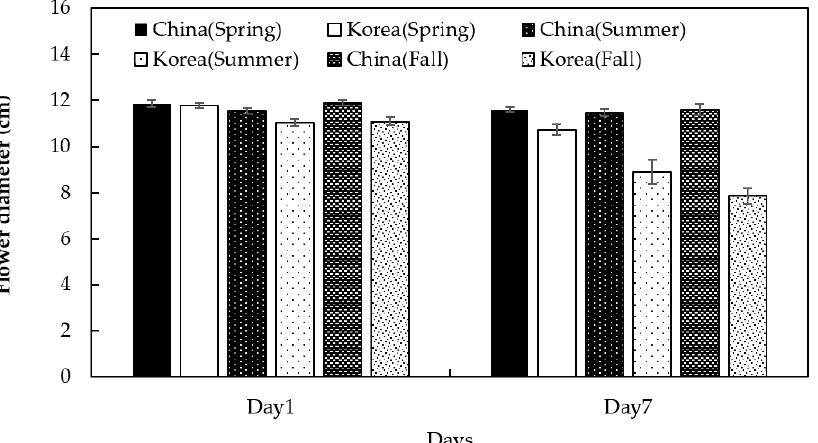
Figure 1. Flower diameter of cut Phalaenopsis “V3” flowers based on the place of origin and season on day 1 and day 7 of the experiment when the senescence type was observed. The relative fresh weight was lower in Korean cut flowers with a shorter vase life than in Chinese flowers on day 5 of the experiment, across all three seasons (Figure 2A), and the margin of decrease was the lowest in autumn when the vase life of the Korean and Chinese cut flowers was longer than during the other seasons. Based on this, the water uptake (Figure 2B) showed an increase on day 3 of the experiment, followed by a decrease on day 5, with lower levels across Korean flowers for all three seasons, as was the case with the relative fresh weight. Phalaenopsis is sold in bloom, but like Curcuma and Oni- sogalum, the leaves do not stick to the stem when cut, making it difficult to increase tran- spiration after harvest [20]. For this reason, it is judged that the water uptake increased at the beginning of the experiment, but deceased later on owing to insufficient water uptake. The water balance (Figure 2C) showed a decrease to below 0 from day 3 of the experiment, and the values were lower in Korean cut flowers, which showed the first signs of senes- cence earlier than the Chinese flowers, reaching the end of the vase life by day 9 of the experiment. This is presumed to be because the Korean flowers did not intake water as efficiently as in the first day compared to the Chinese flowers, affecting the vase life of the cut flower.